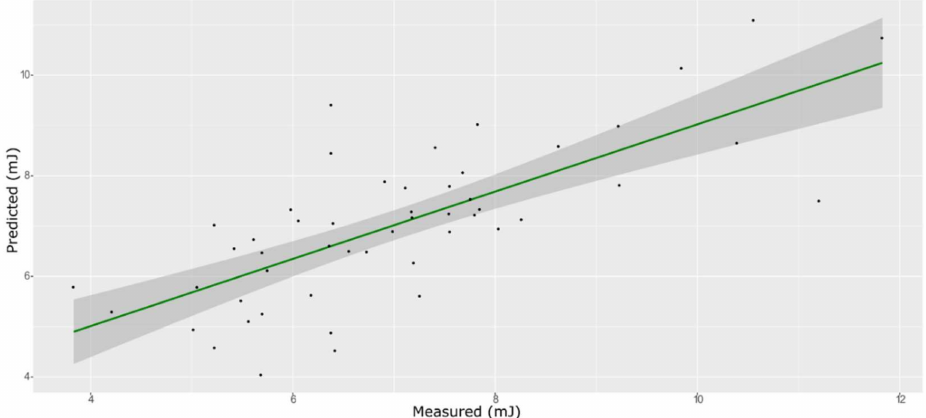
Figure 16. ANN model for BCh on the test set, using the selected